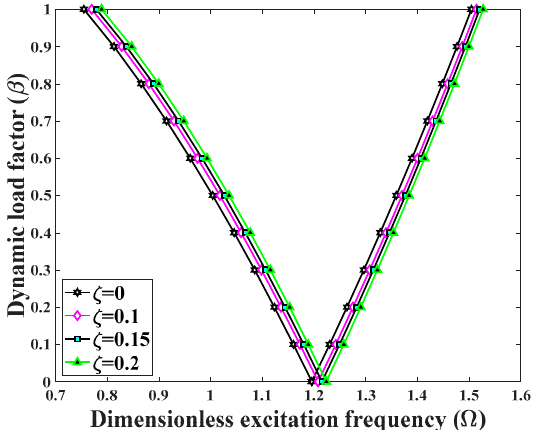
Figure 10. Effect of the even porosity volume fraction ζ on the dimensionless excitation frequency versus the longitudinal and transverse power indexes for a BD-FG porous cylindrical shell with R = 0.5 m, h / R = 0.02, L / R = 1, α = 0.3, β = 0.